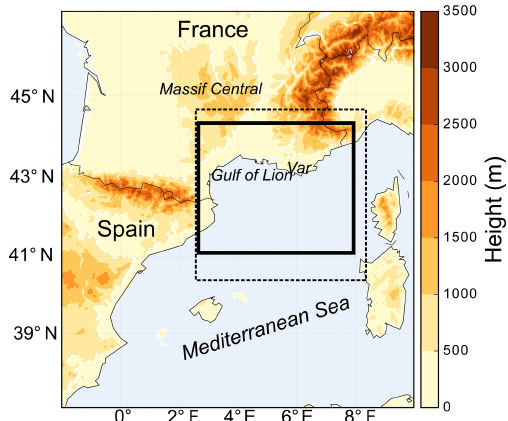
Figure 3. Computational domains used for the outer/coarser do- main (900m, dashed rectangle) and for the inner/finer domain (450 or 150m, thick solid rectangle), respectively (see text for more ex- planation). The model orography (m) is shown in